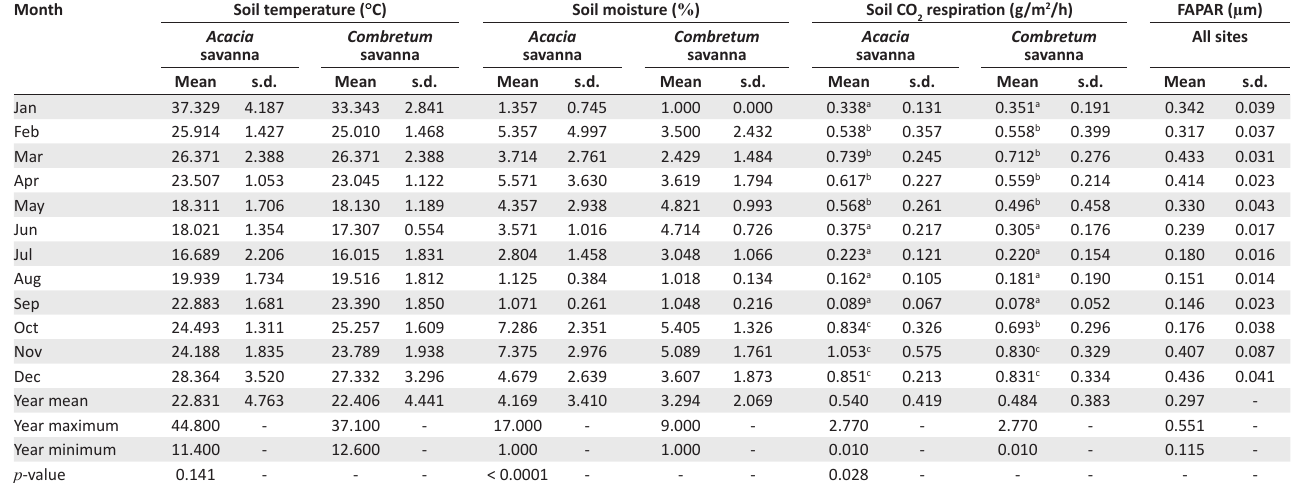
respiration (g/m 2 /h) 2